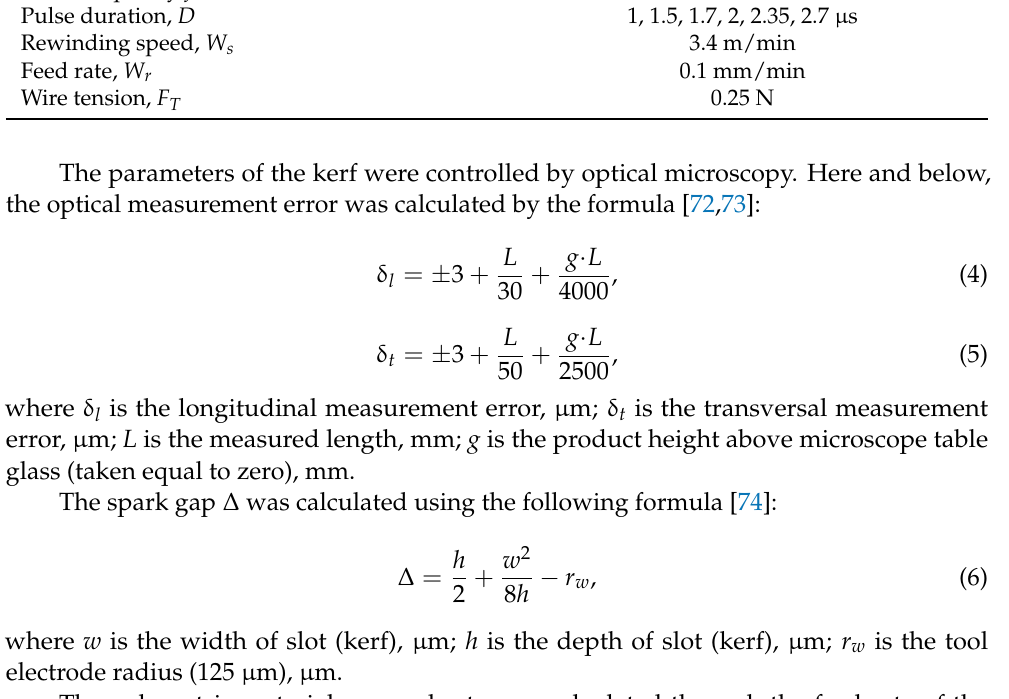
Table 4. The factors chosen for wire electrical discharge machining in the water-based suspension. Factor Value Operational voltage, U o 108 V Pulse frequency, f 10, 15, 20, 25, 30 kHz Pulse duration, D 1, 1.5, 1.7, 2, 2.35, 2.7 µ s Rewinding speed, W s 3.4 m/min Feed rate, W r 0.1 mm/min Wire tension, F T 0.25